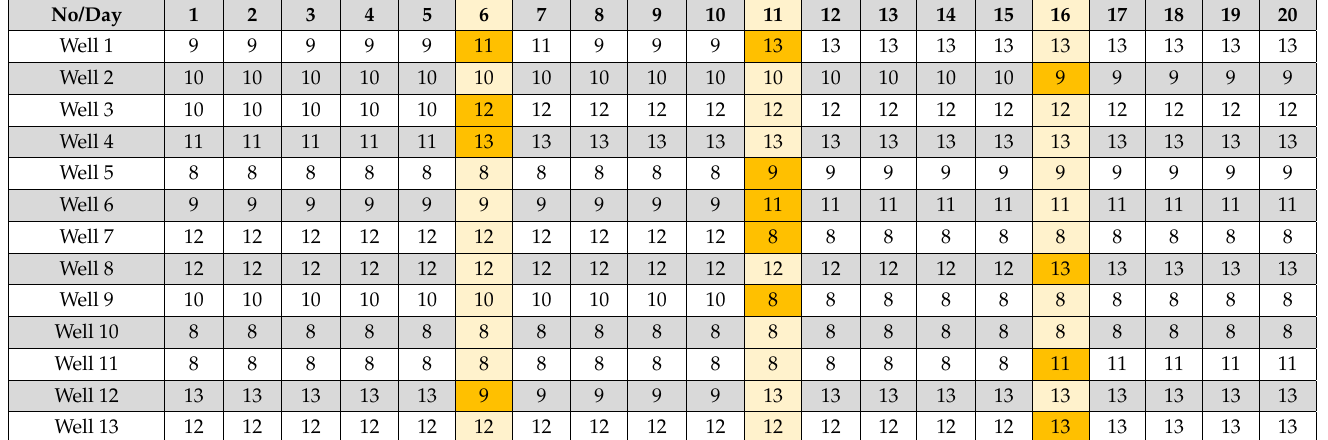
Table 2. Parameter chart for 20 days with the 3-step production